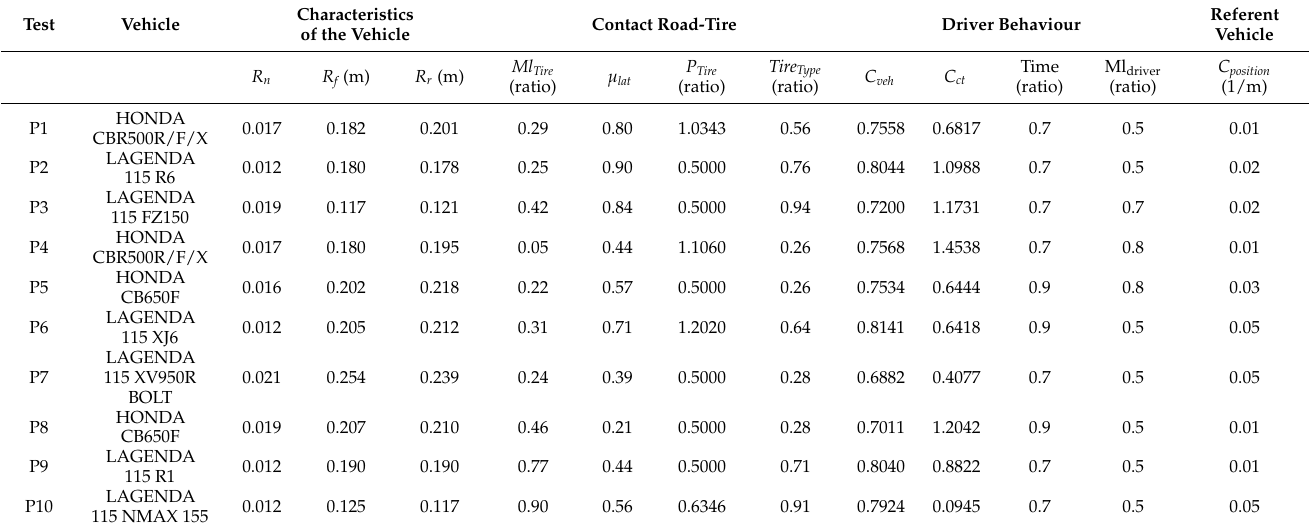
Table 3. Parameter values used in the